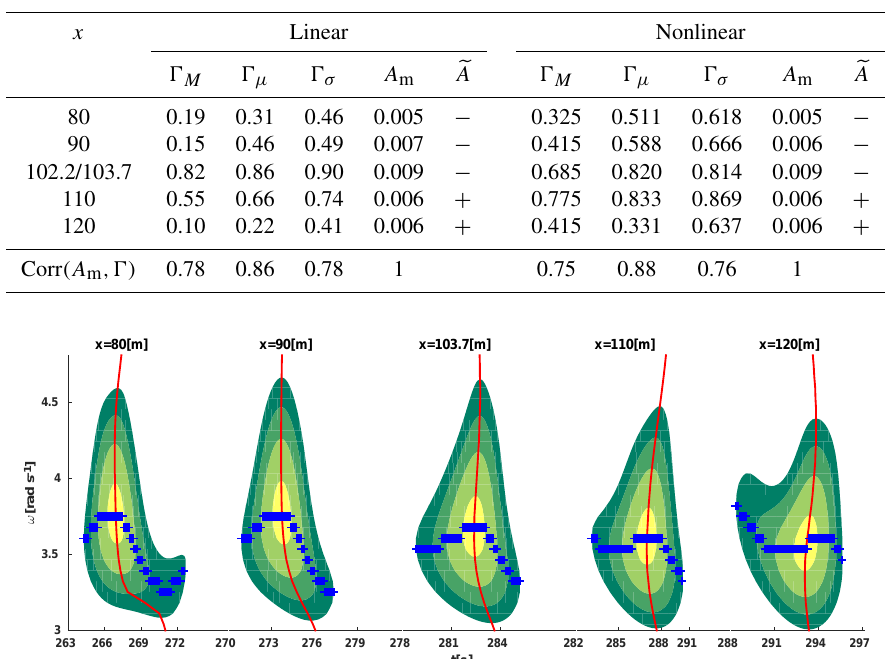
Table 4. Measure of the local coherence of IW12.